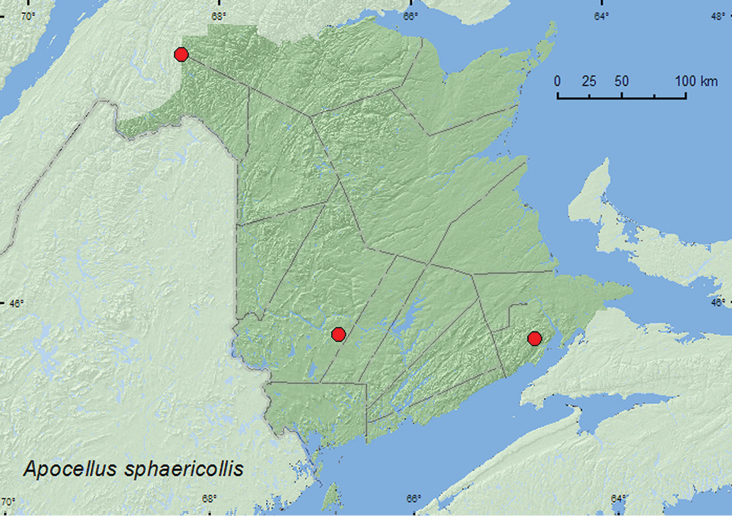
Collection localities in New Brunswick, Canada of Apocellus sphaericollis.